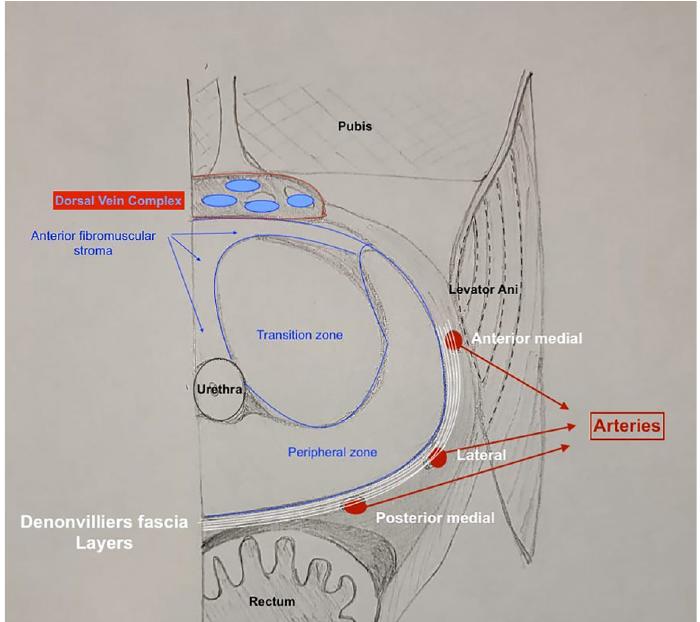
nerve-sparing.Figure 7 - Prostate anatomy describing the arterial landmarks used to guide the nerve-sparing on the right side.